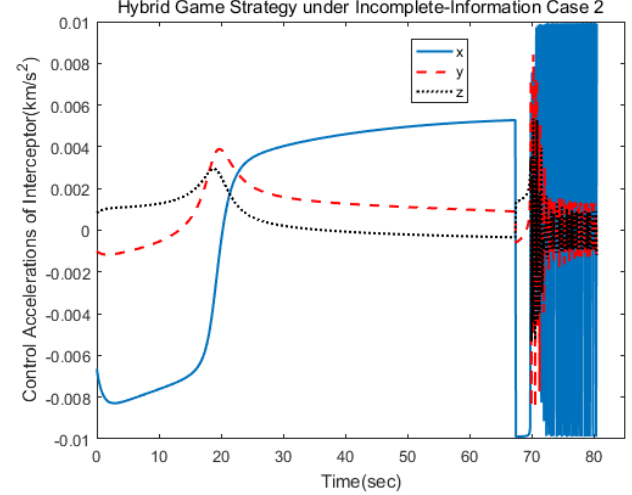
Figure 12. Control acceleration of the pursuer.